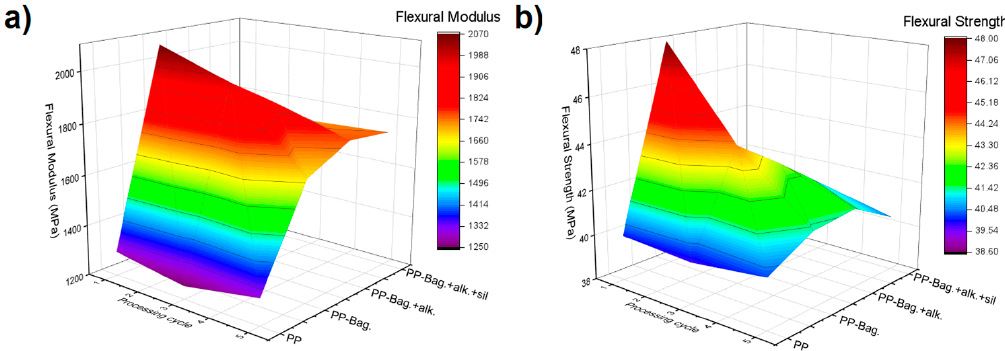
Figure 2. Three-dimensional colormap surface of flexural modulus ( a ) and flexural strength ( b ) of PP and PP-Bagasse